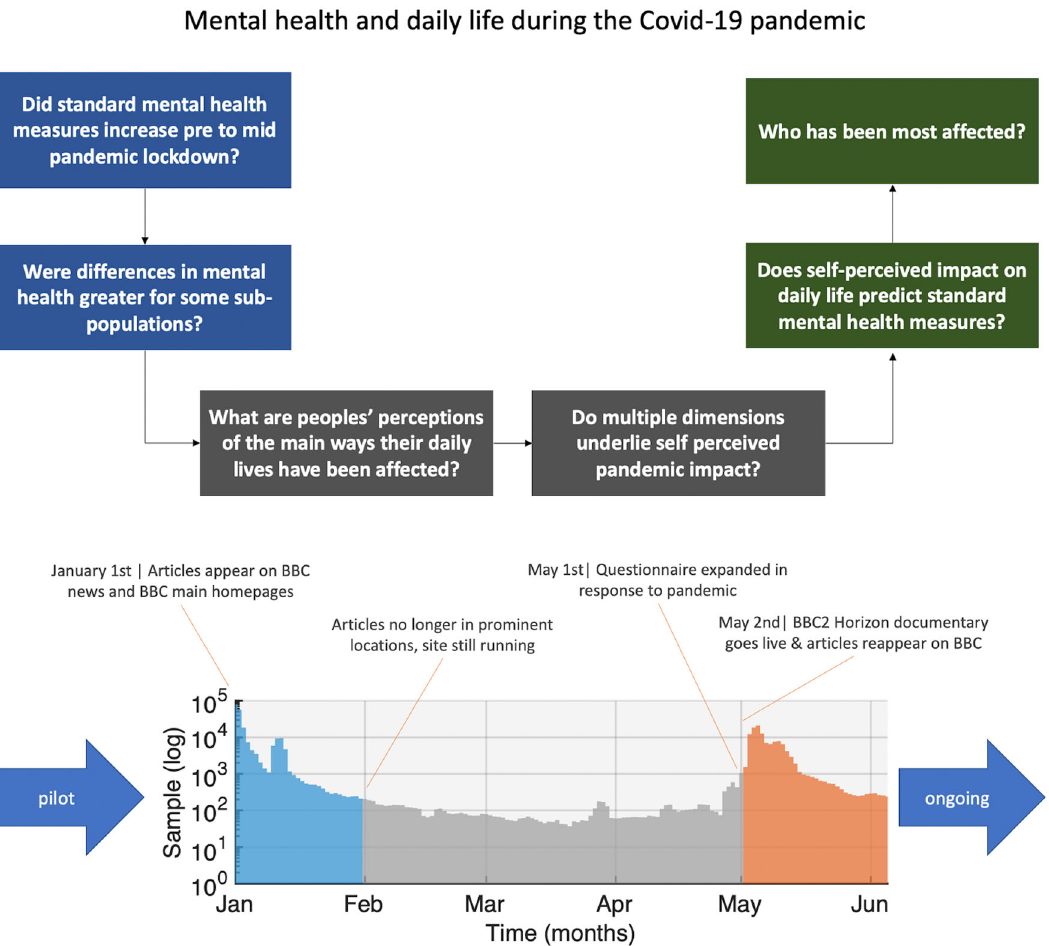
Fig. 1 Study design. Top. We fi rst examine whether standard mental health self-assessment measures differed between the period of time just prior to the pandemic hitting the UK and mid-lockdown, and whether those differences covaried with population factors such as age, education and occupational status. We then analyse peoples ’ self-perceptions of the impact of the pandemic, determining the internal structure and dimensionality of self-perception, and the covariance with population and contextual and lifestyle factors. Bottom. Timecourse of data collection at the time of submission (note, Y axis is a log scale). Large spikes in data collection occurred in January prior to the pandemic hitting the UK and in May at the peak of the fi rst UK-wide lockdown. These pre- and mid-pandemic epochs form the focus of analyses reported in this article. Source data are provided as a Source data fi